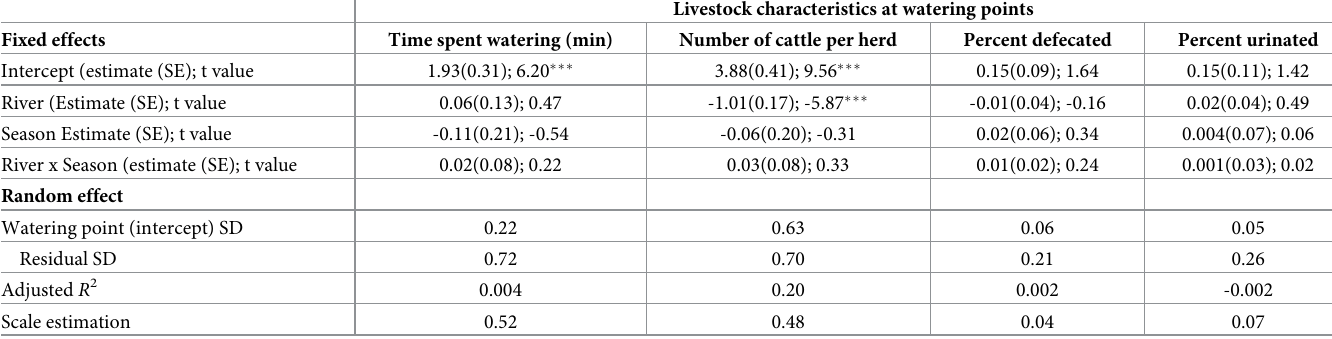
Table 2. Summary of generalized additive mixed models (GAMMs) used to determine the effect of the river system (region) and seasonality (wet and dry seasons) livestock characteristics: Time (minutes) spent at watering points, number of cattle per herd, percentage of cattle defecating or urinating in the river. The ‘full’ model included the river or region (Amala, Nyangores and Talek), season (dry vs. wet) and river X season interaction as fixed effects and watering point as a random effect.